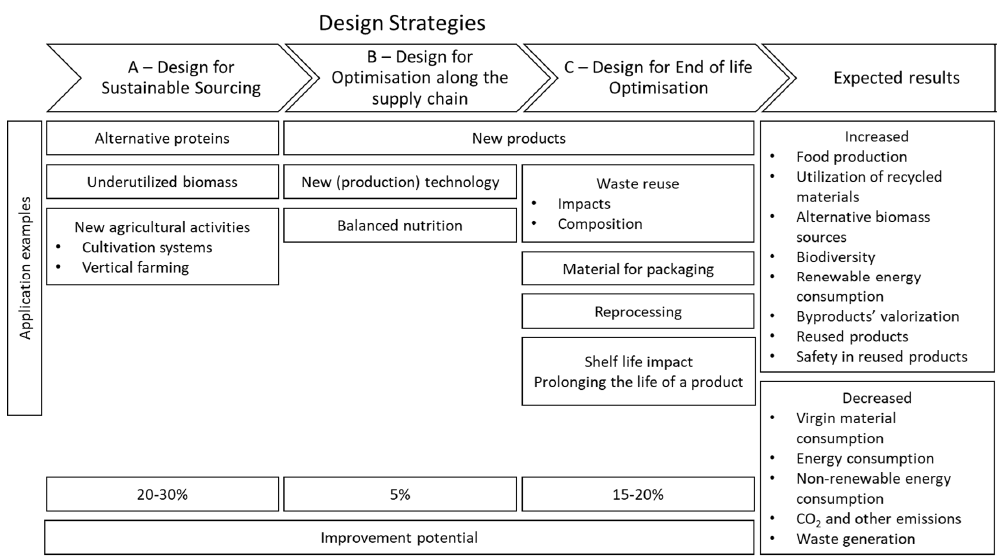
Figure 3. Conceptual ecodesign framework for sustainable food production and compilation of literature suggestions. Implementing the suggested examples can lead to a variable improvement in the system’s environmental impact, from 5% to 30%, depending on the target point. Source: